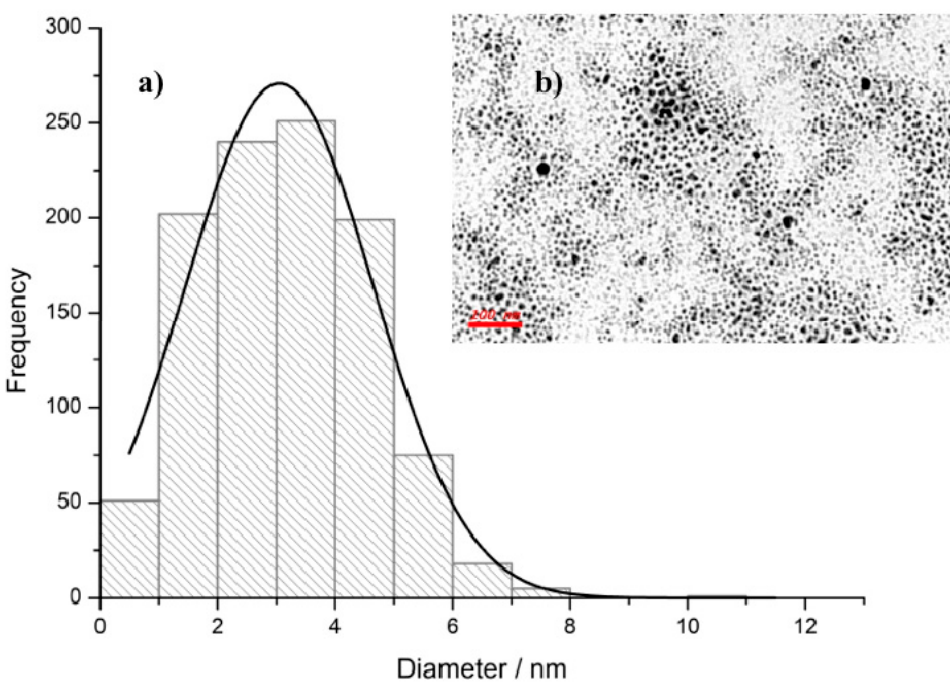
Figure 1. Panel ( a ): particle size distribution histogram indicating high frequency of nanoparticles in the 1–5 nm range and lack of nanoparticles larger than 8 nm. In panel ( b ), a TEM micrograph of the investigated AgNPs is shown (scale bar: 100 nm). The statistical distribution of nanoparticles was obtained by the elaboration of TEM images with the ImageJ program and calculated with StatPlus-2 or Origin software.